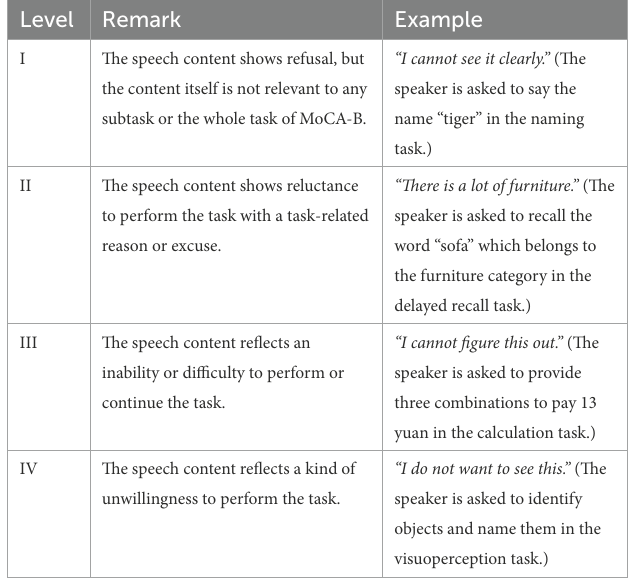
(Table 1) and applied a quantitative approach to explore the average frequency distribution of each level of RIF performed by older adults in every single turn during the examiner-patient interaction. Then, two expression devices (non-verbal acts and prosodic features) and two affecting elements (intentional state and emotional state) related to the performance of the refusal speech act were, respectively, examined through both quantitative and qualitative analysis. Last, the study proposed a preliminary interactive mechanism model of older adults performing the refusal speech act in the cognitive assessment from cognitive, linguistic, and psychological perspectives.